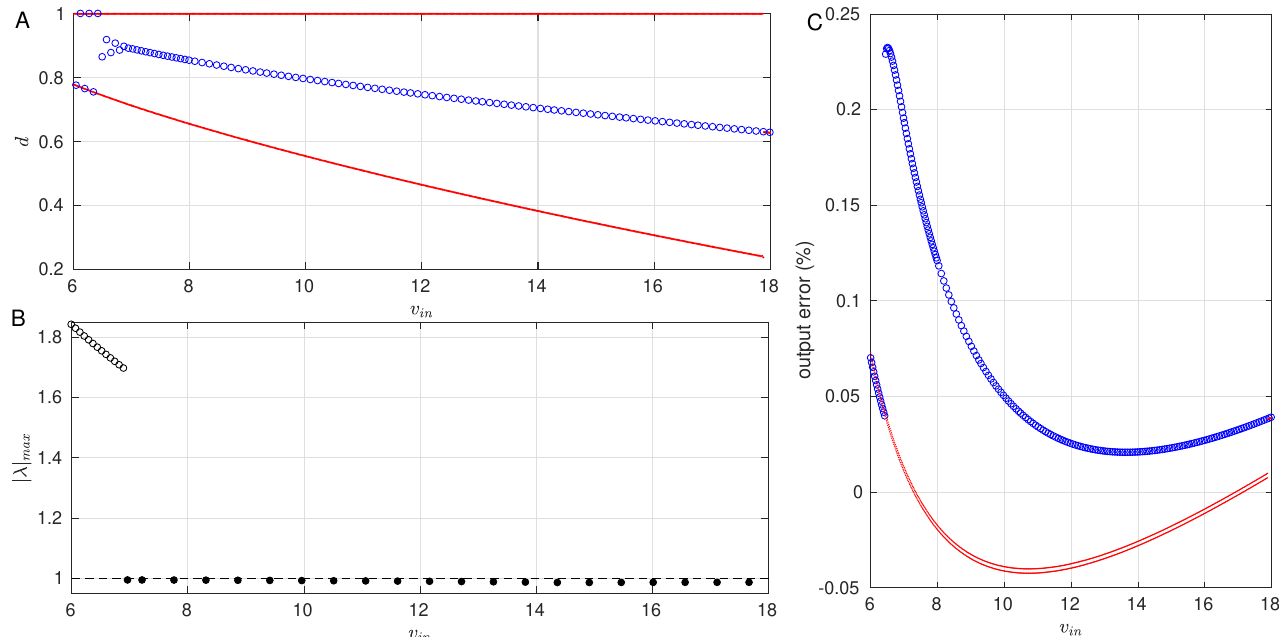
Figure 4. Bifurcations with v in as a control parameter. ( A ). Duty cycle solution (11) in steady state with two protocols: Red (blue) line corresponds to increasing (decreasing) variations of the parameter. ( B ). Maximum Floquet multiplier of the period-1 orbits found in the studied interval. Solid (empty) symbols refer to stable (unstable) orbits. ( C ). Output error of the attractors of panel ( A ), with the same color code. Parameters of this simulation, as in Table